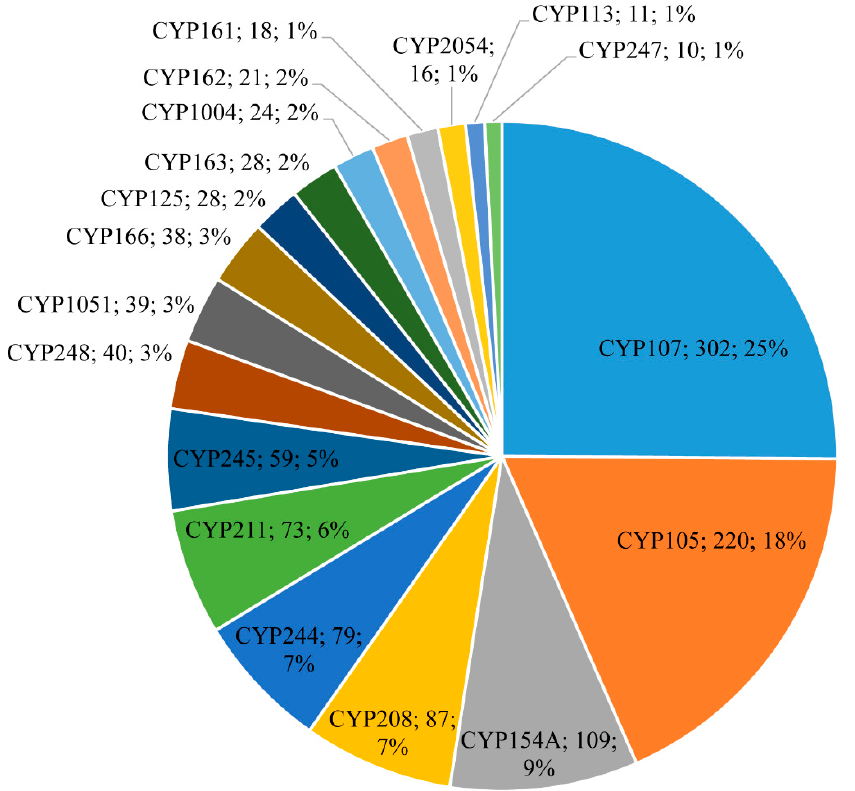
Figure 3. Comparative analysis of P450s associated with secondary metabolism in Salinispora species. The P450 family name, number of P450s, and the percentage of the total number of P450s that are part of secondary metabolite biosynthetic gene clusters (smBGCs) are presented in the figure. Detailed information on secondary metabolite clusters, species, and P450s are shown in Table S1.